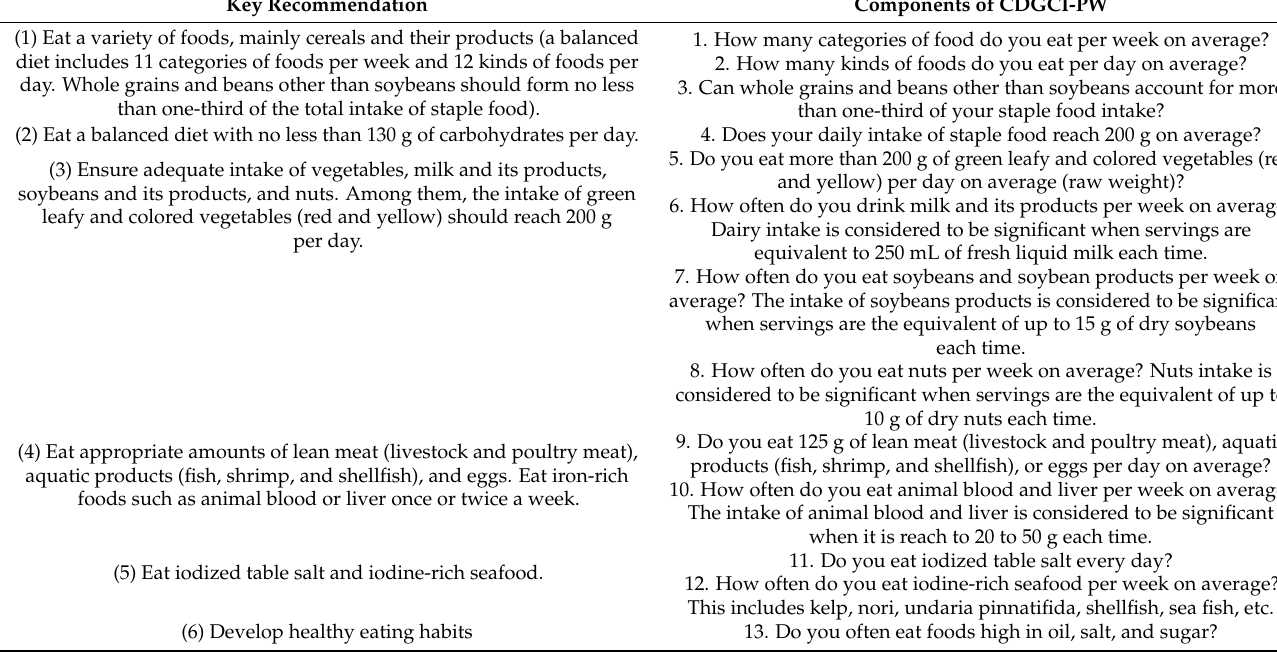
Table 1. Key recommendations of dietary guidelines for pregnant women and components of